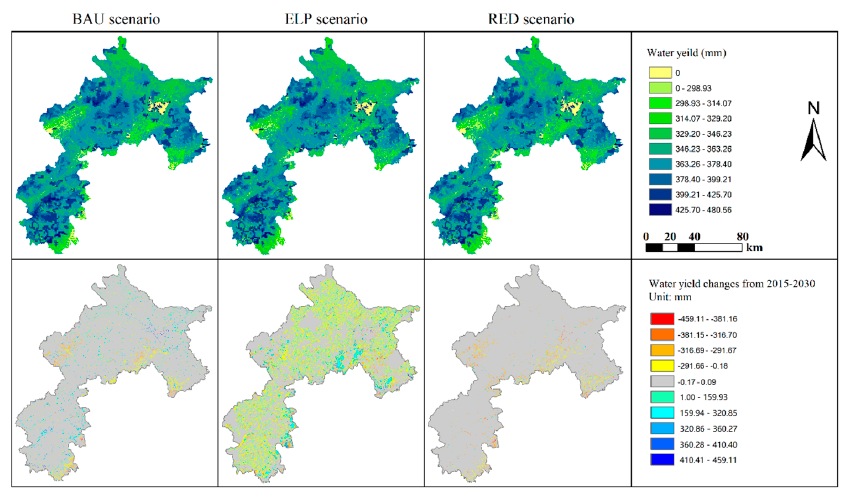
Figure 5. Top, spatial distributions of flood regulation (FR), and bottom, spatial distributions of changes in WY from baseline, in 2030 under the BAU, RED, and ELP scenarios.